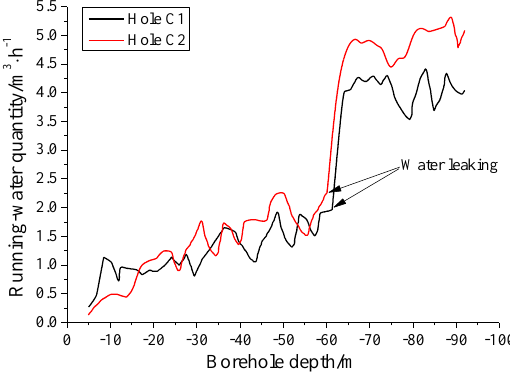
Figure 12. Relationship between the leakage and drilling depth.